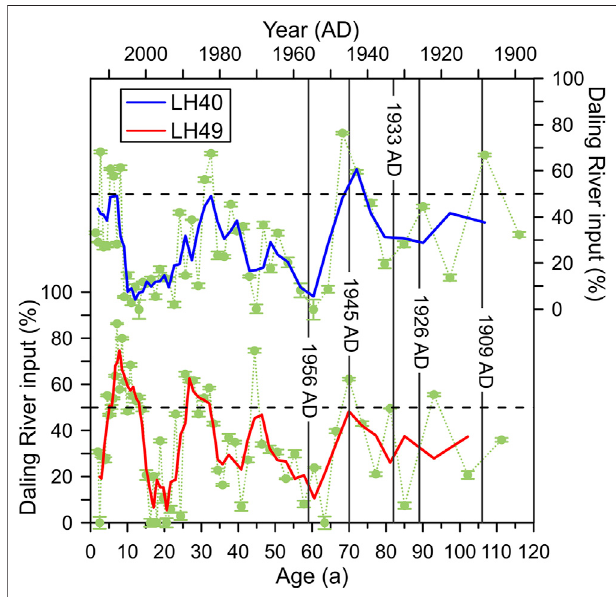
FIGURE 9 | Reconstruction of the Daling River contribution in the last century using the two dated cores LH40 and LH49. The solid lines in blue and red demonstrate a 3-point running